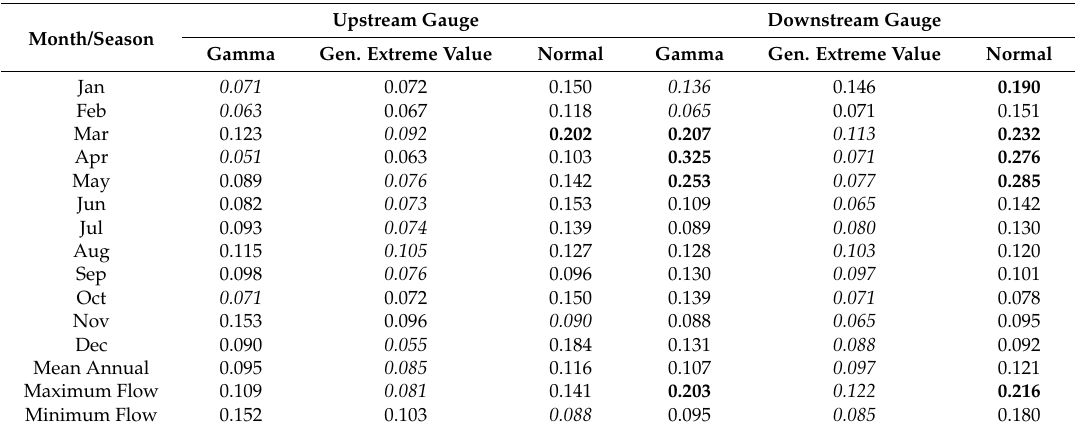
Table 1. Kolmogorov–Smirnov test statistics obtained during the fitting distribution of river flow on the upstream and downstream side gauge data of the